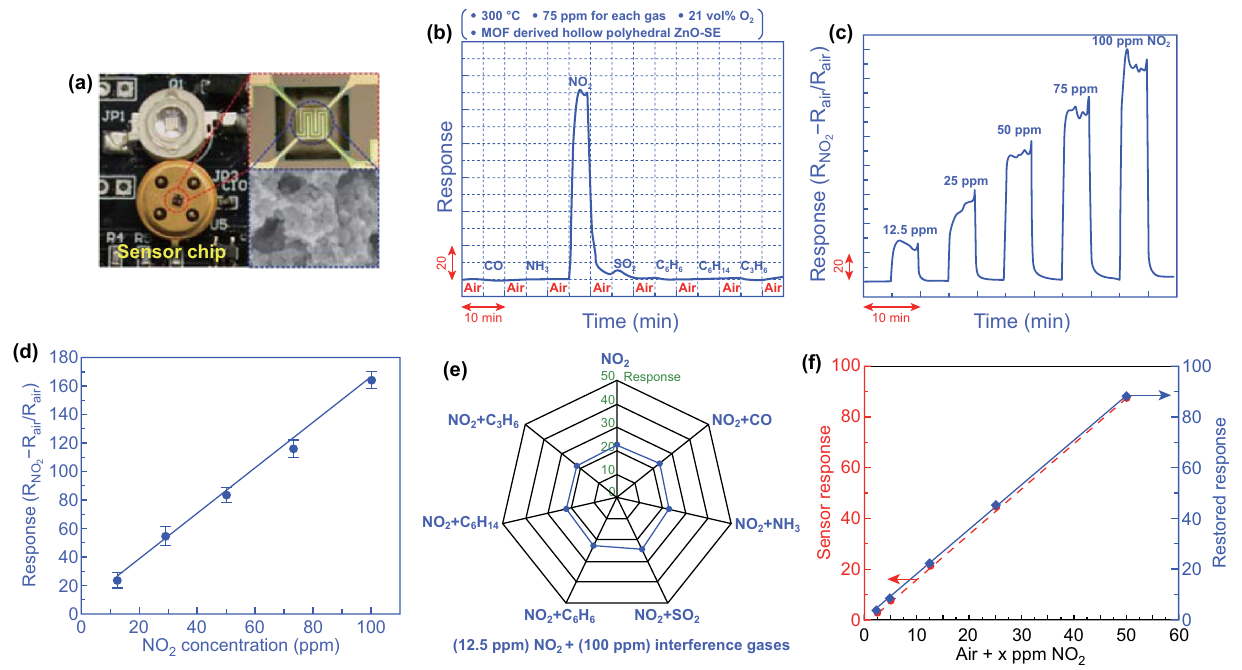
Fig. 5 Sensing characteristics of the smart device: a Photography of the sensor chip made by photolithography technique; b Cross-sensitivity, c dynamic response-recovery variation, and d dependence of response signal on the NO 2 concentration of the MEMS sensor consisting of the hollow polyhedral ZnO, operated at 300 °C. e Comparison of the sensing behavior to NO 2 against other interference gases for the smart device, recorded at light on. f Consistence of the response signal that is generated or restored by the smart device or signal processing terminal to the gas mixture. The gas mixture is defined as the air mixed with x ppm NO 2 in which x ranges from 2.5 to 50